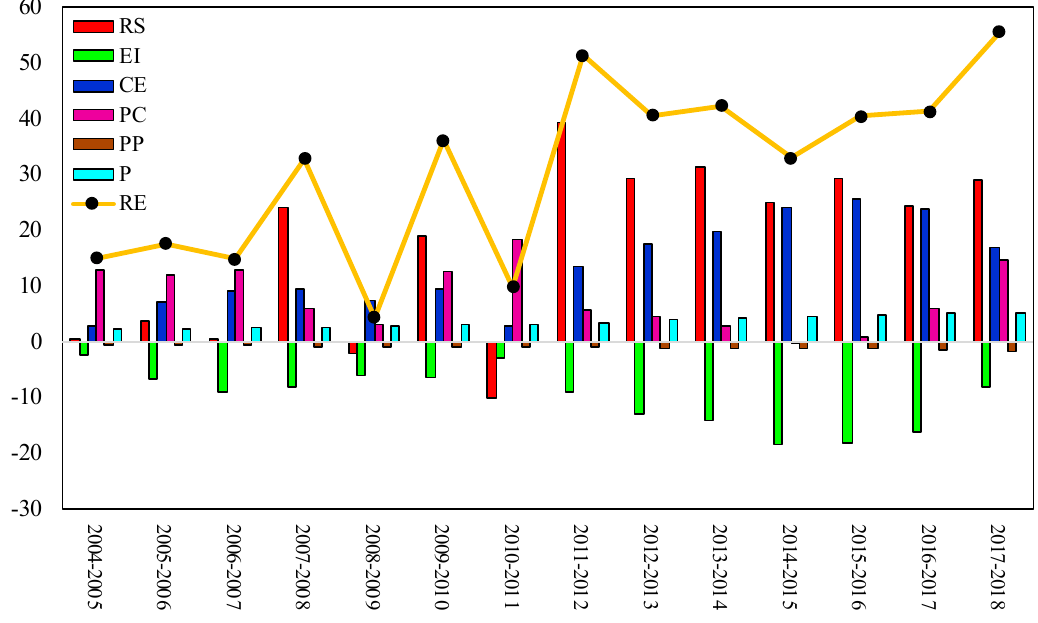
Figure 4. Specific contribution amount of each factor.